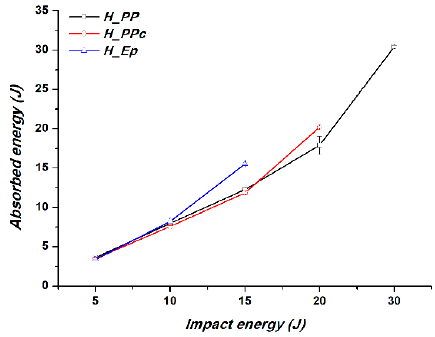
Figure 8. Impact energy vs. absorbed energy curves at various impact energy levels and matrix type.